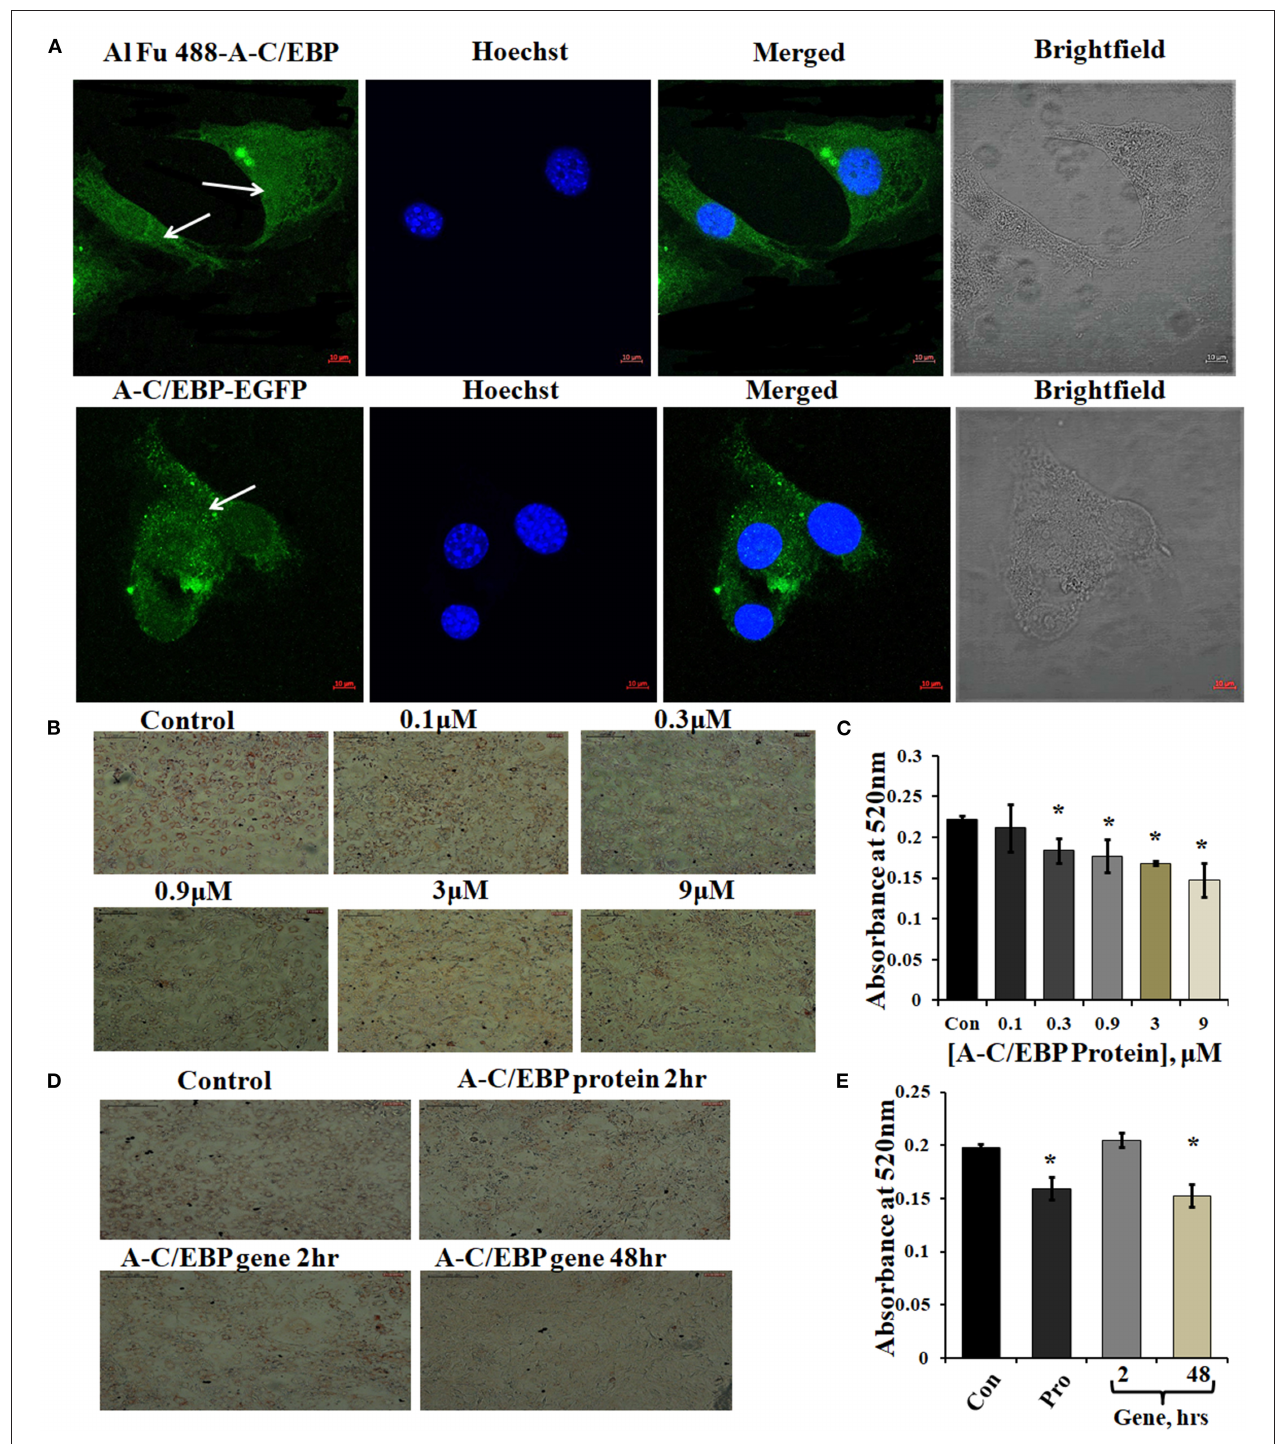
FIGURE 1 | Localization of protein in the cytoplasm and ORO staining of transfected and differentiated cells. (A) Image representing Alexa Fluor (Al Fu) 488 and EGFP-tagged protein inside the cytoplasm; arrows depict the presence of tagged A-C/EBP in the cytoplasm, counterstained with Hoechst 33342; magnification = 40 × , scale bar = 10 µ m. (B) Representation of ORO-stained cells transfected with A-C/EBP protein at different concentrations along with untreated cells. Half-log concentrations of A-C/EBP protein were taken. Magnification = 10 × , scale bar = 200 µ m. (C) Quantification of ORO-stained samples treated with A-C/EBP protein. Absorbance was taken at 520nm, and isopropanol was taken as blank. (D) Image representing ORO staining of cells transfected with A-C/EBP protein and gene; magnification = 10 × , scale bar = 200 µ m. (E) Quantification of ORO-stained samples treated with A-C/EBP protein and gene, absorbance was taken at 520nm, and isopropanol was taken as blank. *Significantly different from control ( p <